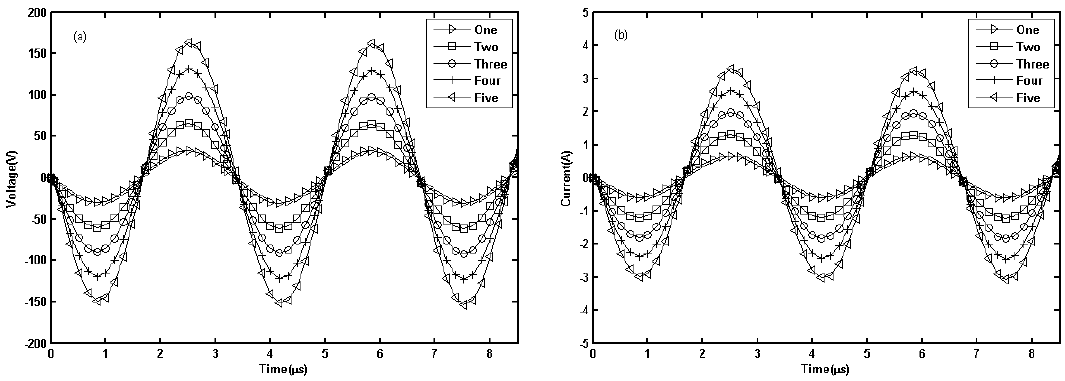
Figure 2. Simulation result of the linear PA with different numbers of LAMs: ( a ) voltage; ( b ) current.